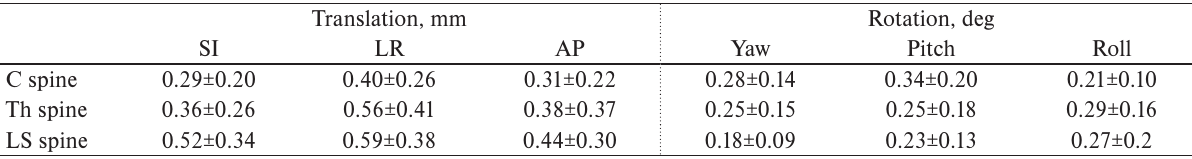
Table 2. Interfraction spine variability for translations and rotations during SBRT treatment in the cervical (C), thoracic (Th) and lumbar-sacral (LS) regions of the spine.